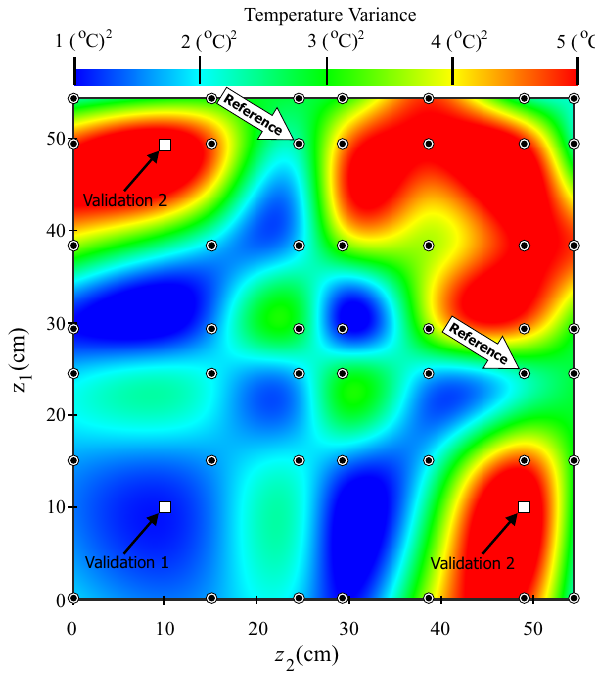
Figure 10. Temperature variance using cubic spline